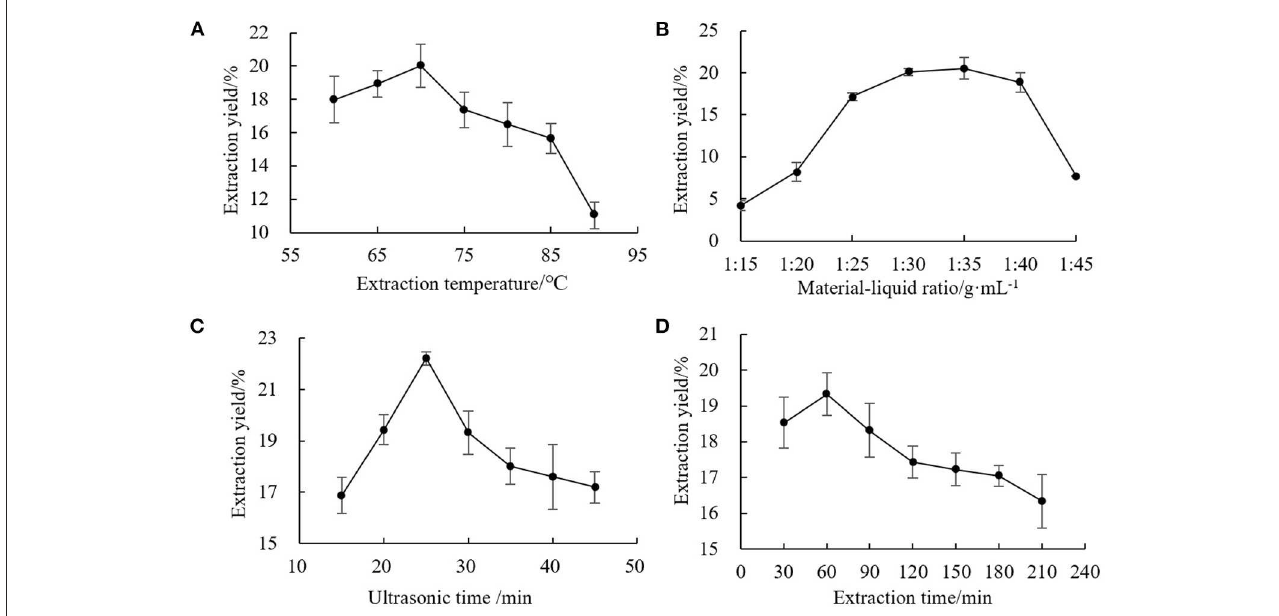
extraction temperature, 70 ◦ C; solid-liquid ratio, 1:35 g · mL − 1